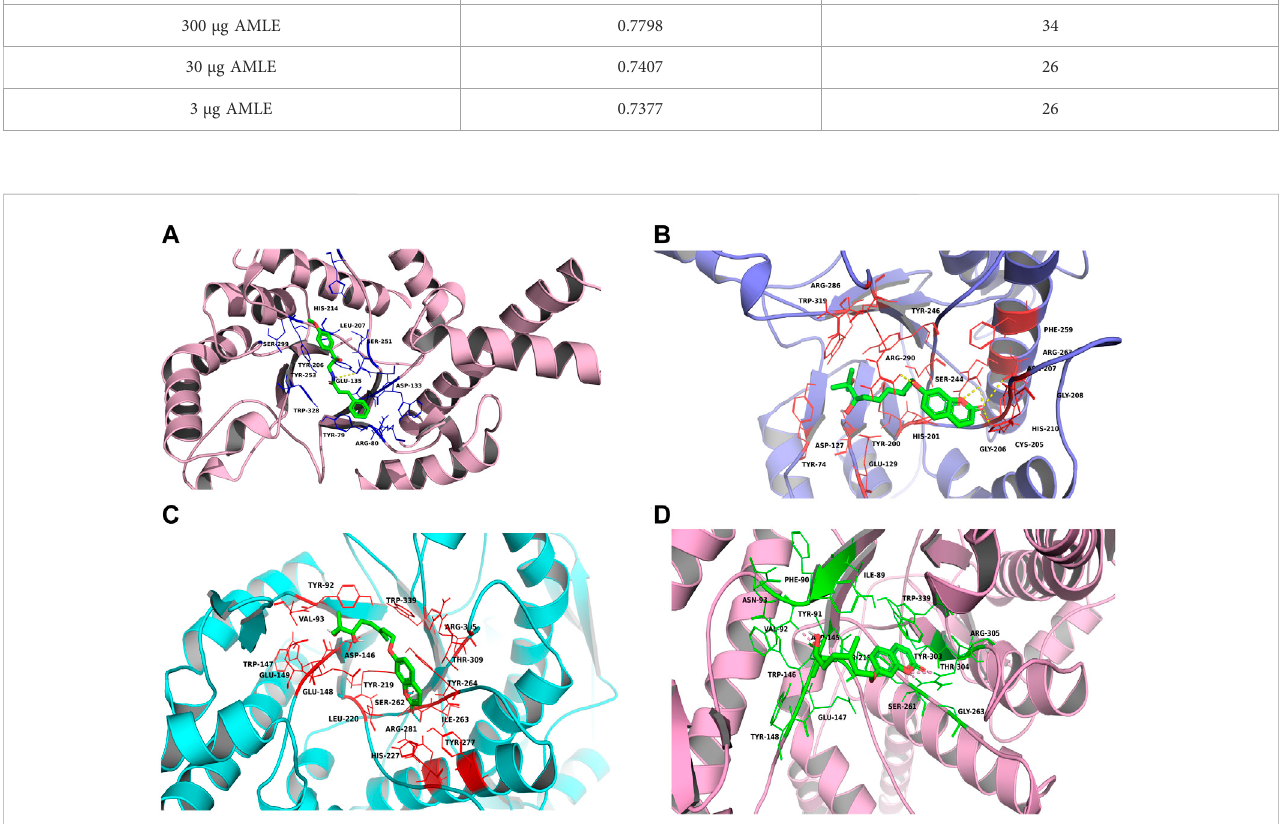
FIGURE 6 (A – D) : (Clockwise) Molecular interaction of aegeline with HYAL-2 marmenol with HYAL-3, marmin with HYAL-4, marmin with HYALPH20 in the substrate and active site